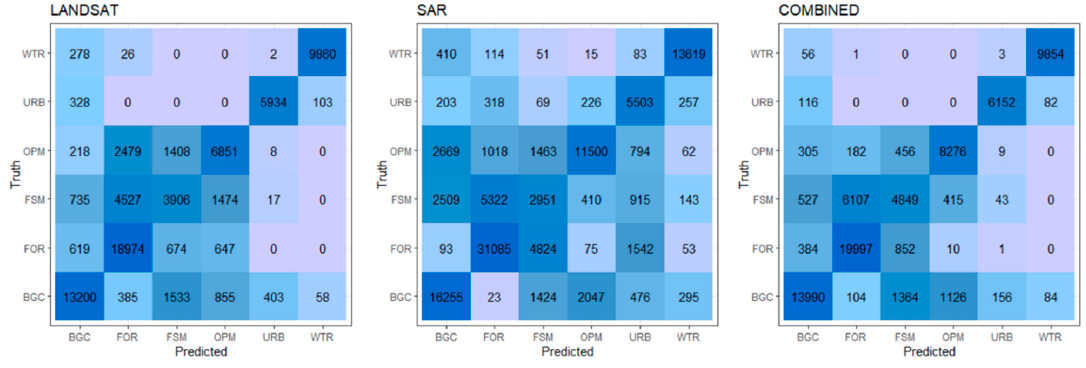
Figure 4. Error matrices of the three classifications for Landsat, SAR, and Combined maps. Values in each cell represent the number of testing pixels for each land-cover class.